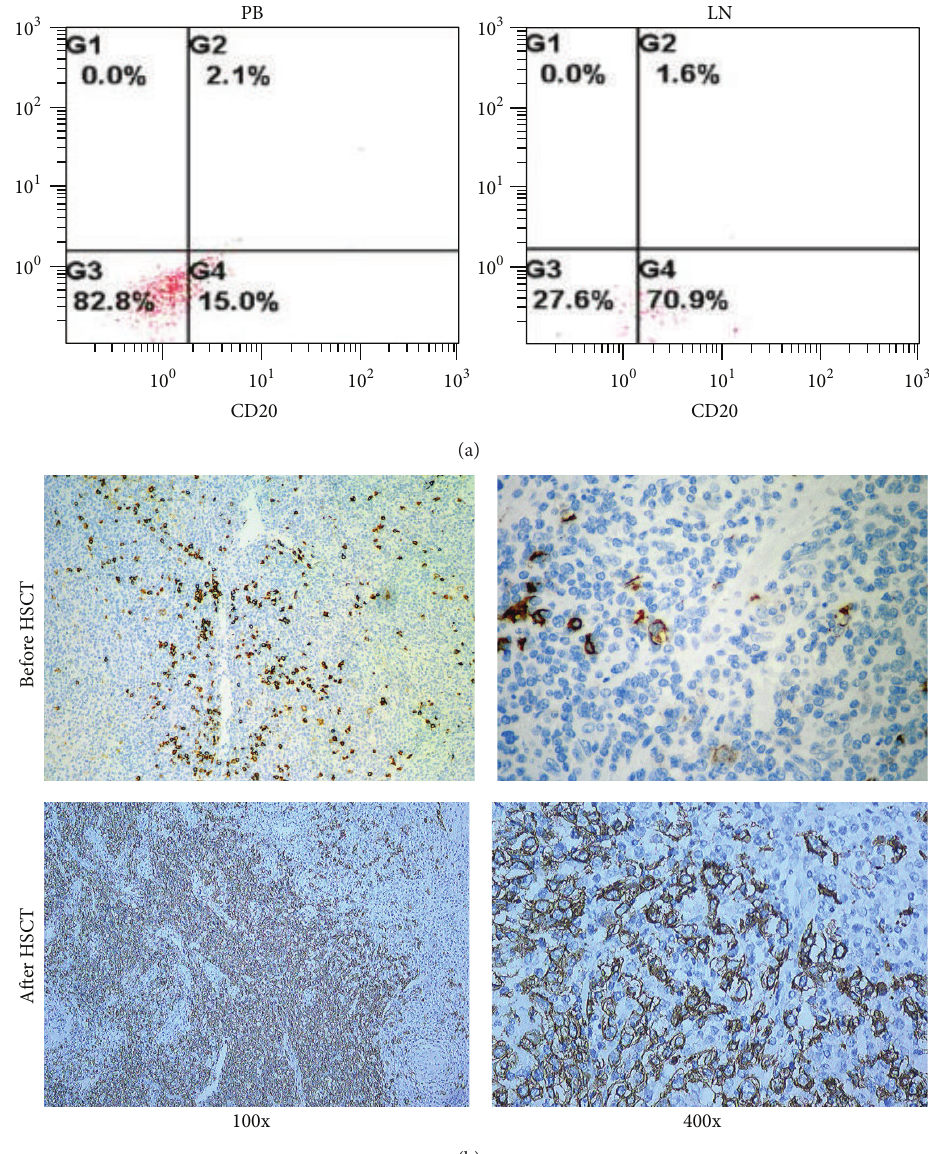
Figure 2: CD20 expression in the LN. The patient underwent lymph node (LN) biopsy. (a) After the operation, LN was grinded to prepare LN suspension. The lymphocytes of LN and peripheral blood (PB) were stained for CD2, CD3, CD5, CD7, HLA-DR, CD10, CD34, CD8, CD23, FMC7, CD79b, CD79a, CyCD3, and CD20. A representative flow pattern of CD20 was shown. (b) Further confirmation of CD20 expression in pathology slides. The pathology slides were stain of anti-CD20 by standard immunohistochemistry staining. Pathology was shown before and after HSCT separately (100x and